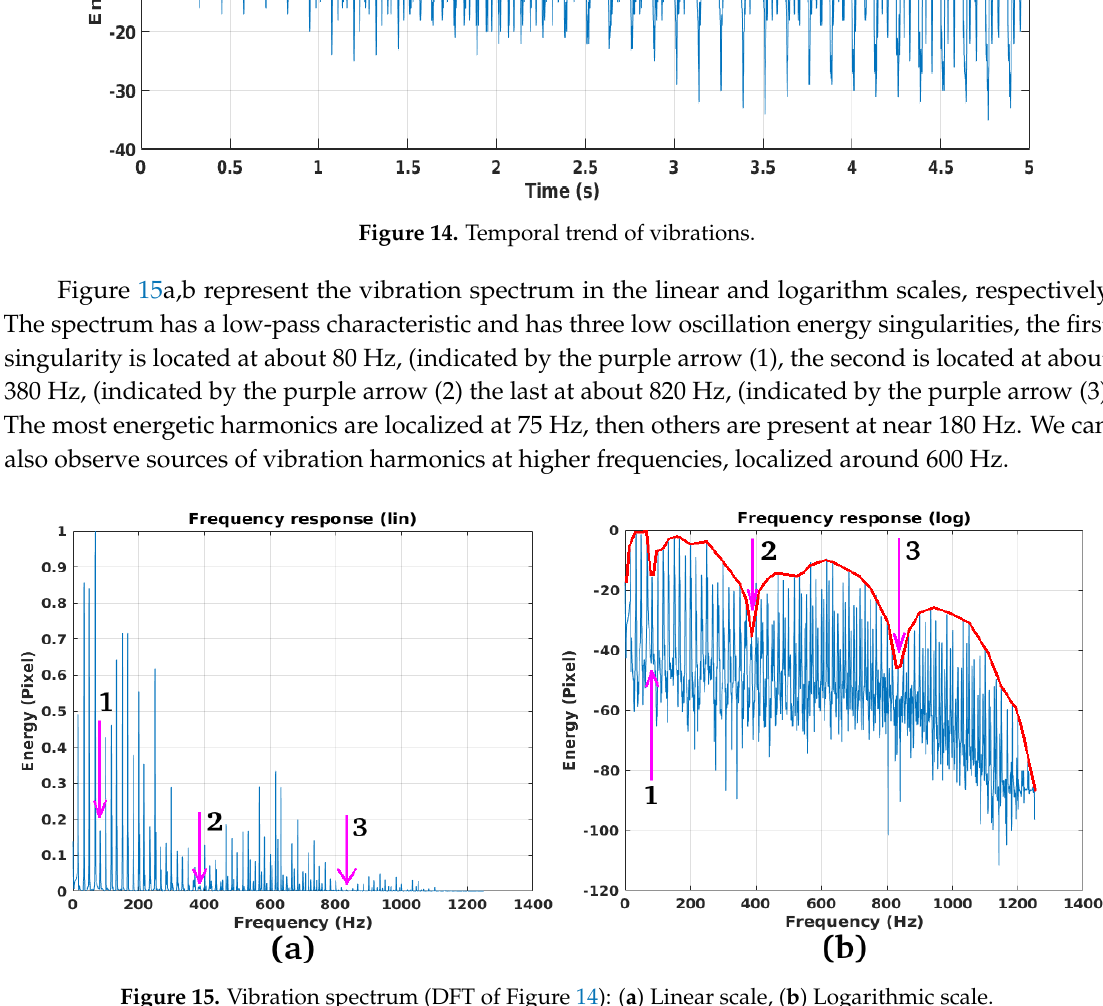
Figure 15. Vibration spectrum (DFT of Figure 14): ( a ) Linear scale, ( b ) Logarithmic